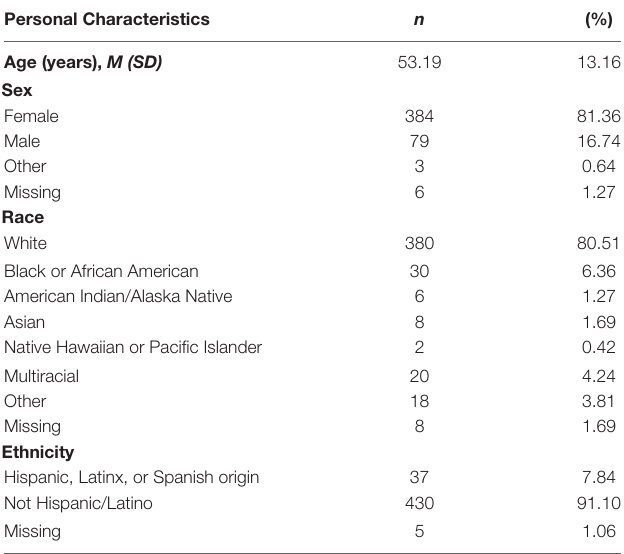
TABLE 2 | Personal characteristics of TMH providers ( N =